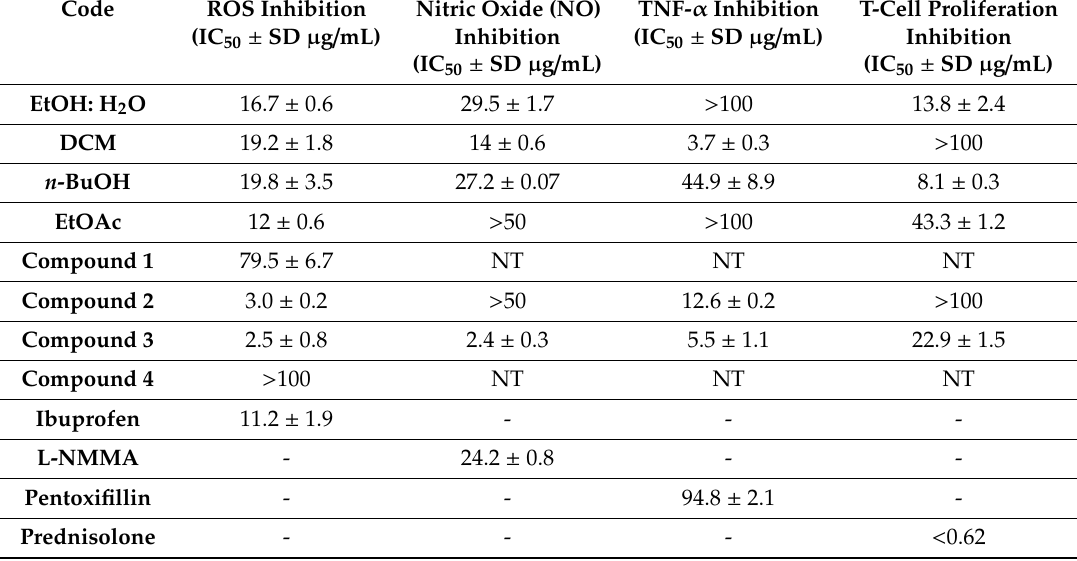
Table 1. Anti-inflammatory parameters as tested by the extracts and compounds isolated from the aerial parts of T. aphylla